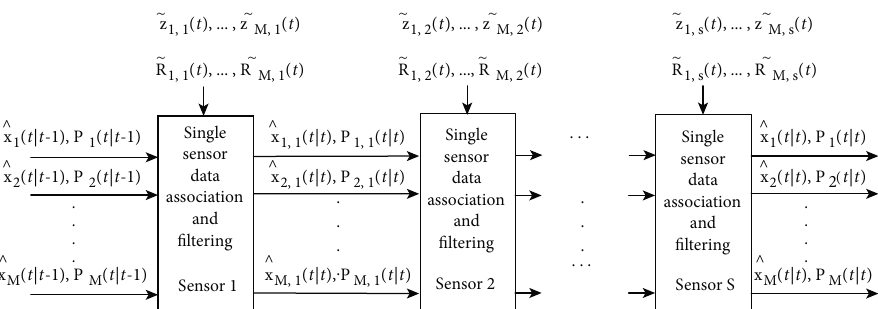
Figure 2: Sequential fusion implementation of multiple Table 2: The fi ve targets ’ initial position and velocity. Target